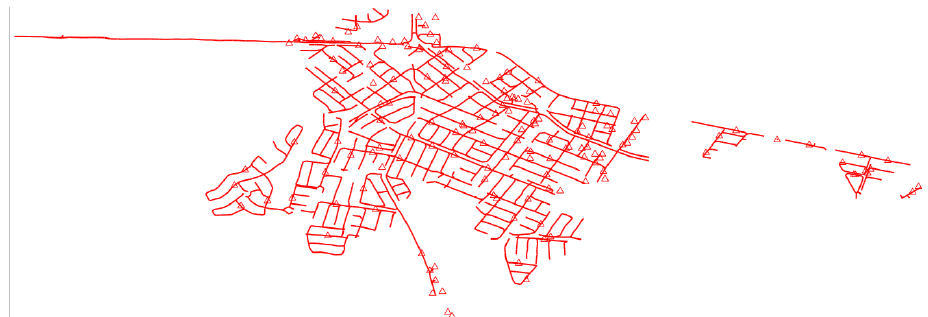
Figure 4. Feeder- α low voltage circuit